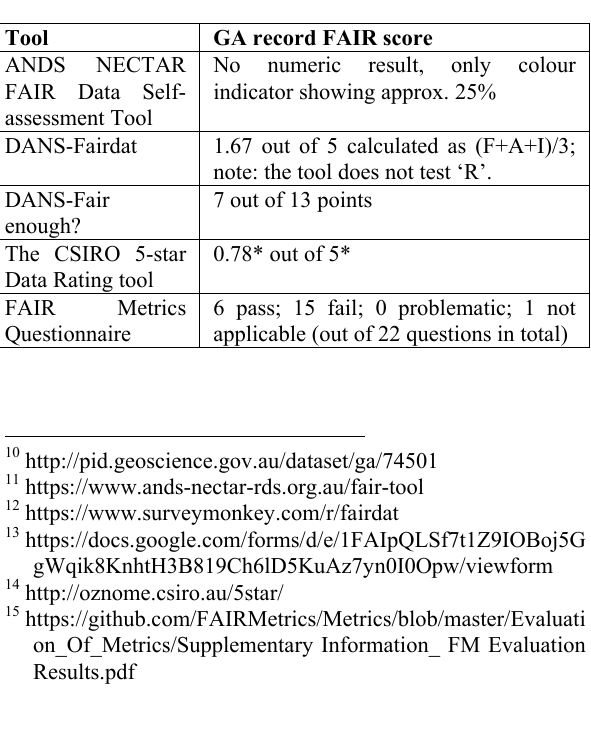
Table 3 FAIRness status of geodetic data